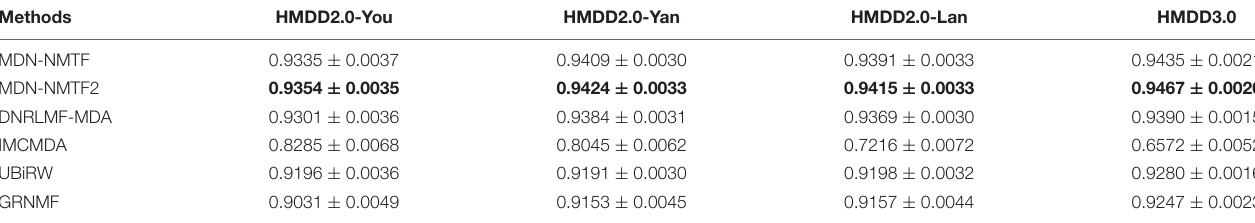
TABLE 2 | The AUC values for the models on different databases by randomly zeroing cross validation.